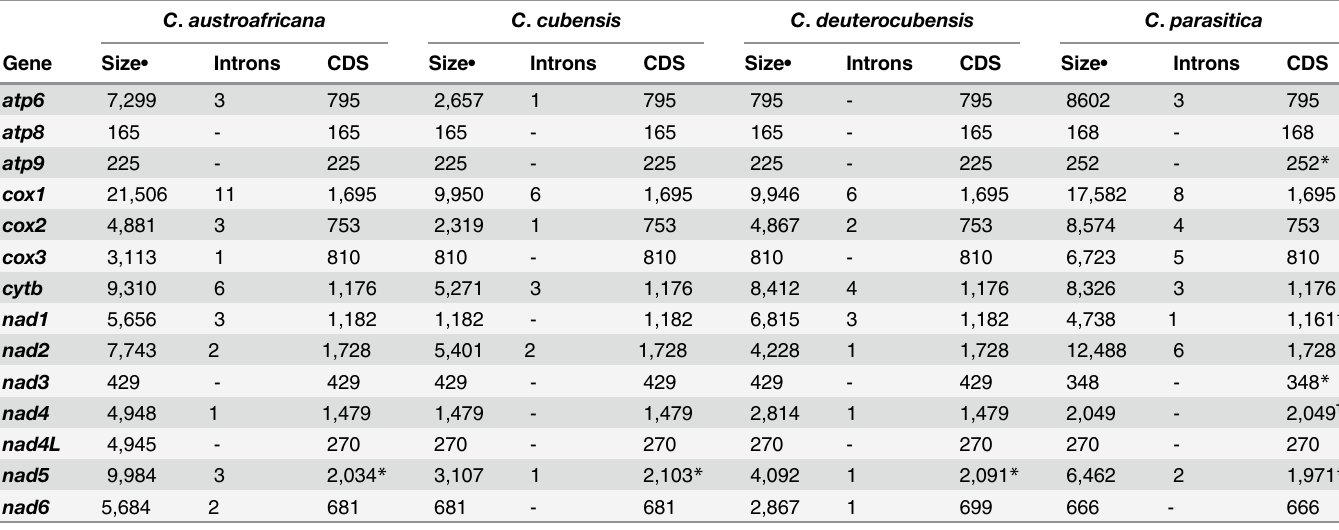
Table 3. Comparison of gene size and number of introns. Comparisons were performed for the 14 mitochondrial genes of Chrysoporthe austroafricana , C . cubensis , C . deuterocubensis and Cryphonectria parasitica involved in oxidative phosphorylation and electron transport. Refer to Fig 1 and S4 Fig for physical maps of these genomes.